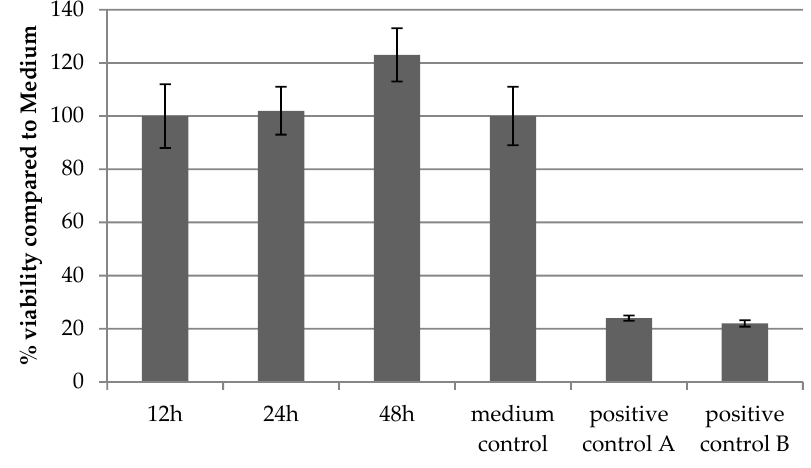
Figure 3. Confirmation of biocompatibility of PLA disks. MTT-tests were performed analogue to ISO 10993-5 and confirmed the biocompatibility of PLA disks as demonstrated by viability of cells after incubation for 12, 24 and 48 h in PLA medium, respectively, compared to standard cell medium. Medium control: standard cultivation medium; positive controls: ZDEC and ZDBC: polyurethane matrices stabilized with organic zinc.